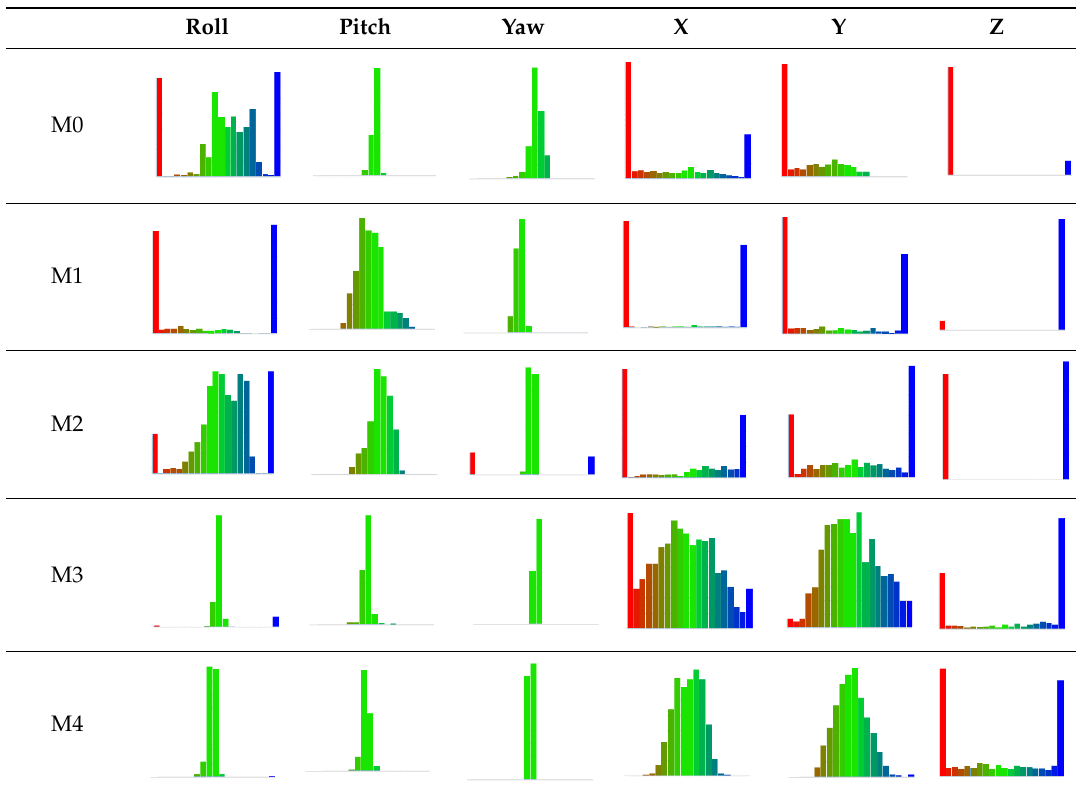
small deviations (green). Table 8. Histogram of deviations for the measured data. The normal to the tag was parallel with the Table 8. Histogram of deviations for the measured data. The normal to the tag was parallel with the Table 8. Histogram of deviations for the measured data. The normal to the tag was parallel with the Table 8. Histogram of deviations for the measured data. The normal to the tag was parallel with the Table 8. Histogram of deviations for the measured data. The normal to the tag was parallel with the Table 8. Histogram of deviations for the measured data. The normal to the tag was parallel with the Table 8. Histogram of deviations for the measured data. The normal to the tag was parallel with the Table 8. Histogram of deviations for the measured data. The normal to the tag was parallel with the Table 8. Histogram of deviations for the measured data. The normal to the tag was parallel with the Table 8. Histogram of deviations for the measured data. The normal to the tag was parallel with the Table 8. Histogram of deviations for the measured data. The normal to the tag was parallel with the Table 8. Histogram of deviations for the measured data. The normal to the tag was parallel with the camera Z-axis. The bars further from the center of the bar graph represent the count of measurements camera Z-axis. The bars further from the center of the bar graph represent the count of measurements camera Z-axis. The bars further from the center of the bar graph represent the count of measurements camera Z-axis. The bars further from the center of the bar graph represent the count of measurements camera Z-axis. The bars further from the center of the bar graph represent the count of measurements camera Z-axis. The bars further from the center of the bar graph represent the count of measurements camera Z-axis. The bars further from the center of the bar graph represent the count of measurements camera Z-axis. The bars further from the center of the bar graph represent the count of measurements camera Z-axis. The bars further from the center of the bar graph represent the count of measurements camera Z-axis. The bars further from the center of the bar graph represent the count of measurements camera Z-axis. The bars further from the center of the bar graph represent the count of measurements camera Z-axis. The bars further from the center of the bar graph represent the count of measurements camera Z-axis. The bars further from the center of the bar graph represent the count of measurements with more significant deviations. with more significant deviations. with more significant deviations. with more significant deviations. with more significant deviations. with more significant deviations. with more significant deviations. with more significant deviations. with more significant deviations. with more significant deviations. with more significant deviations. with more significant deviations. with more significant deviations.